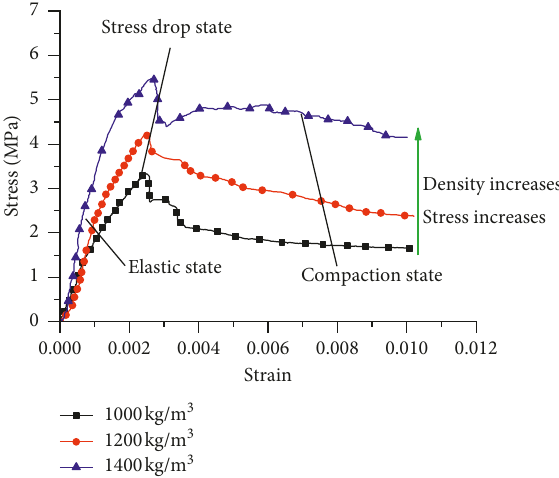
Figure 20: Quasistatic stress-strain curves of the foam concrete with sand.